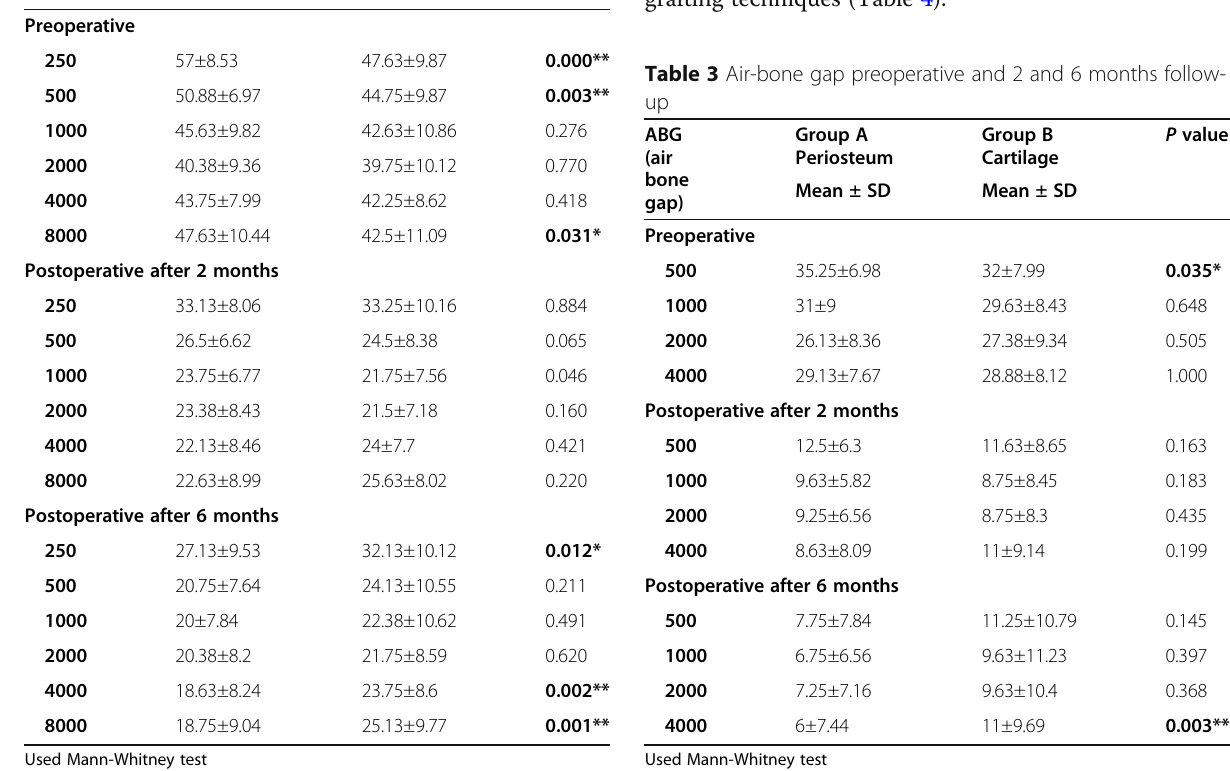
Group B ( n =40) Cartilage